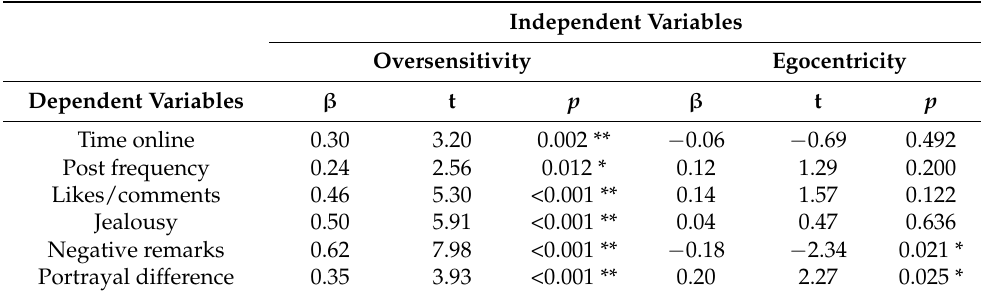
Table 2. Summary of multiple regression analyses for oversensitivity and egocentricity scores in relation to social media variables. Independent